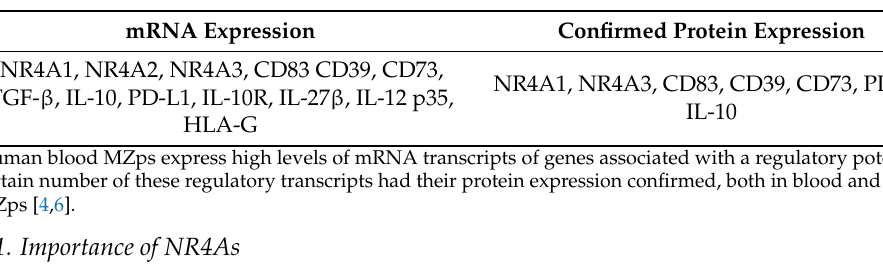
Table 2. The regulatory molecules expressed by human blood and tonsillar